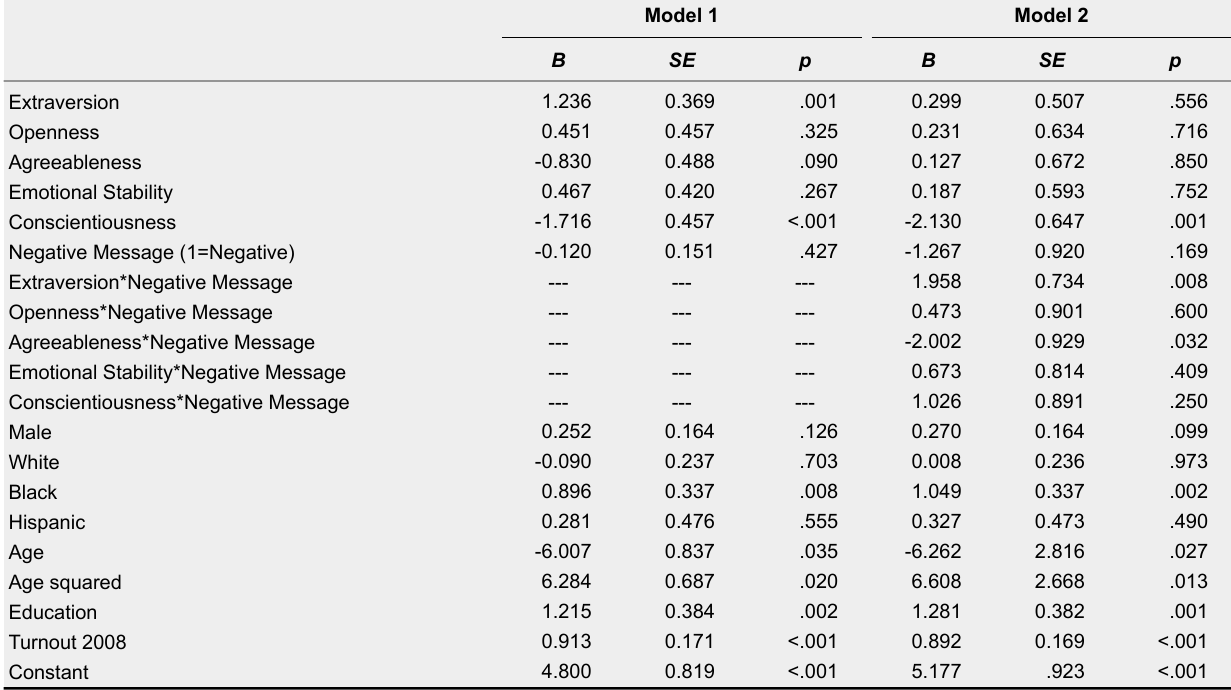
Linear Regression Models (OLS) of Intended Political Participation (N = 724)